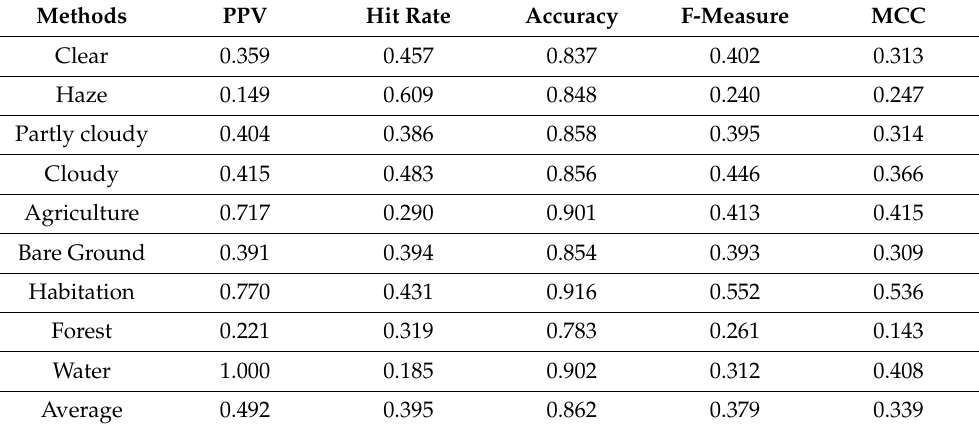
Table 3. Result analysis of MobileNet model with different measures.